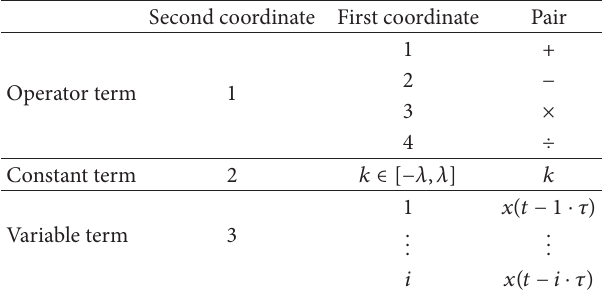
Table 1: Encoding rule of equation